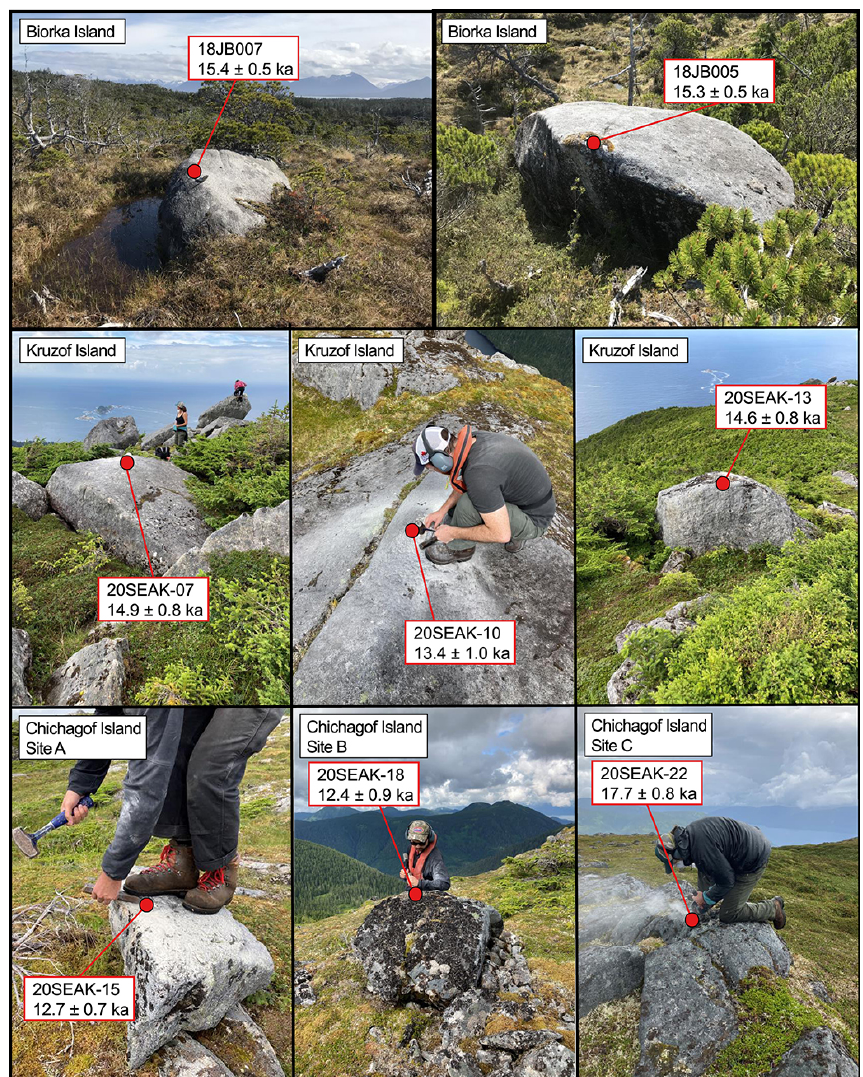
Figure 4. Sample photos from 2018 and 2020 field season. All 10 Be ages are shown with 1 σ internal uncertainty. Note the relatively small size of